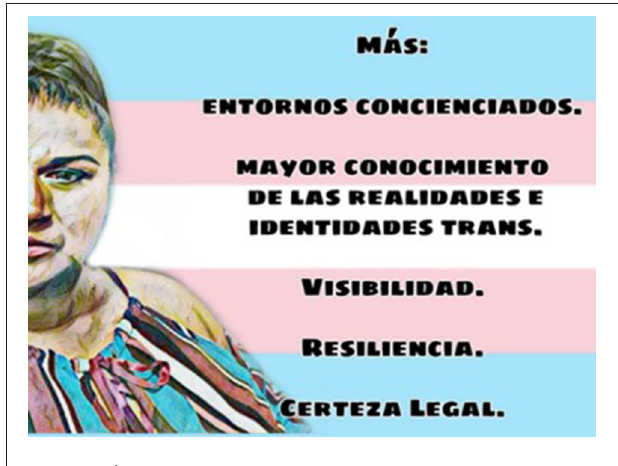
of transgender migrants. Beyond that, there are also specific recommendations to advance policy, programs and